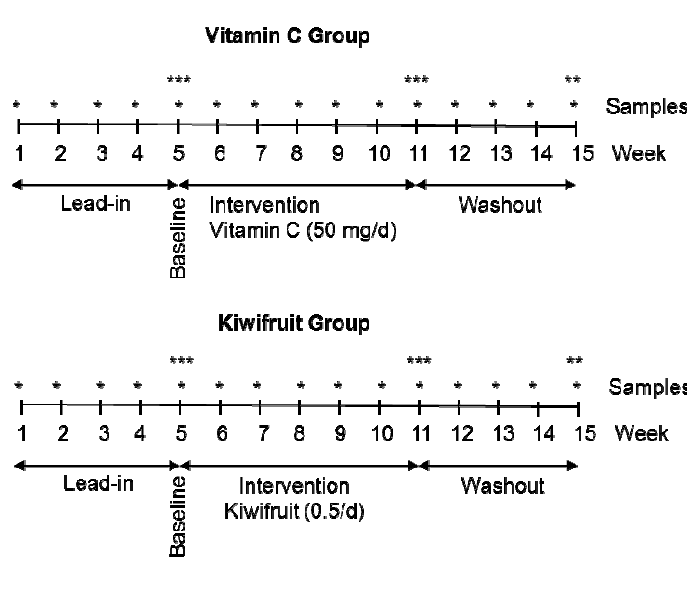
Figure 1. Parallel groups study design. * Weekly plasma samples; ** urine, semen and leukocyte samples; *** urine, semen, leukocyte and skeletal muscle